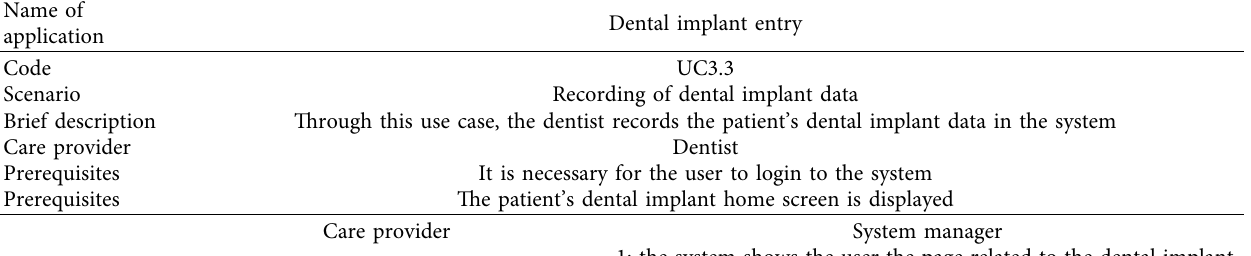
Table 2: Scenario related to the recording of dental implant data in DIR.